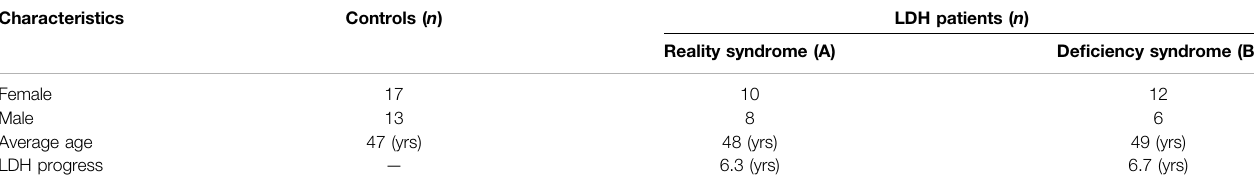
TABLE 1 | Basic characteristics of